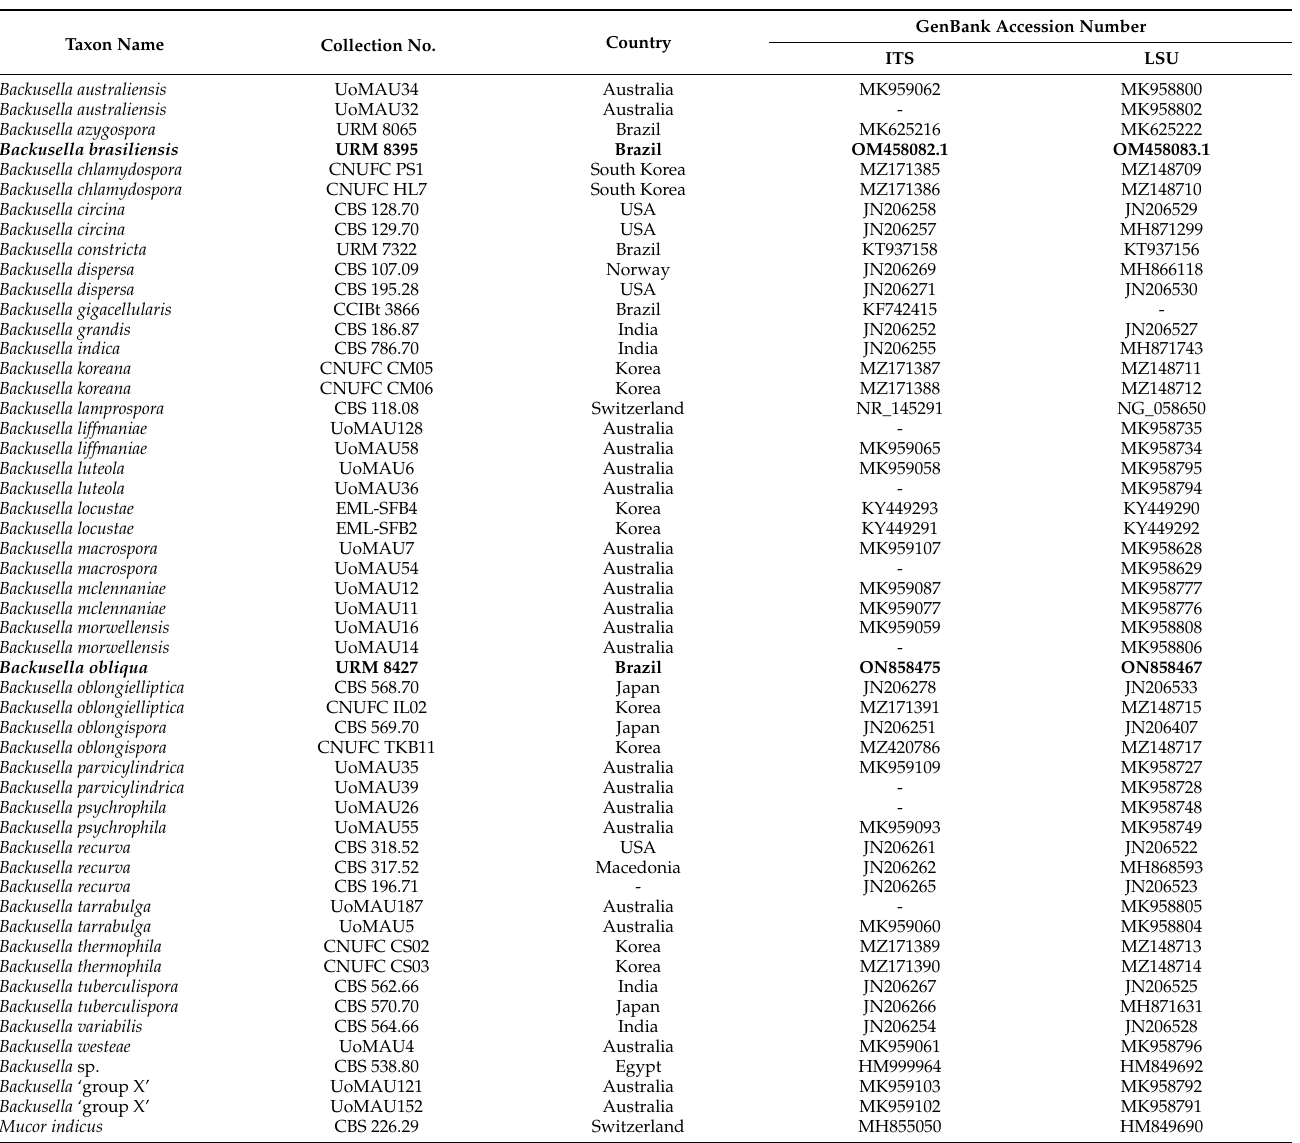
Table 1. Culture collection accession numbers and voucher numbers of sequences used for the phylogenetic